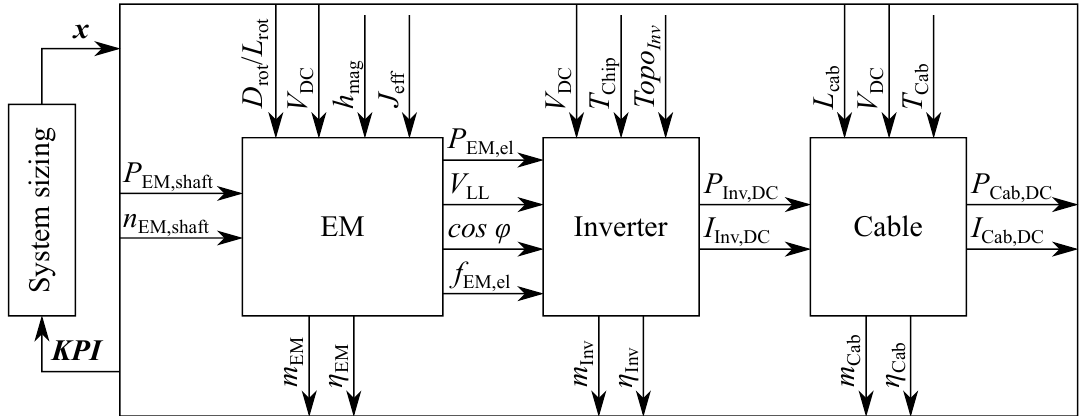
Figure 3. Block diagram of FF drive unit including motor, inverter and cable. For sake of simplicity only one inverter-cable configuration instead of all eight parallel lanes which feed the winding systems of the electric motor is